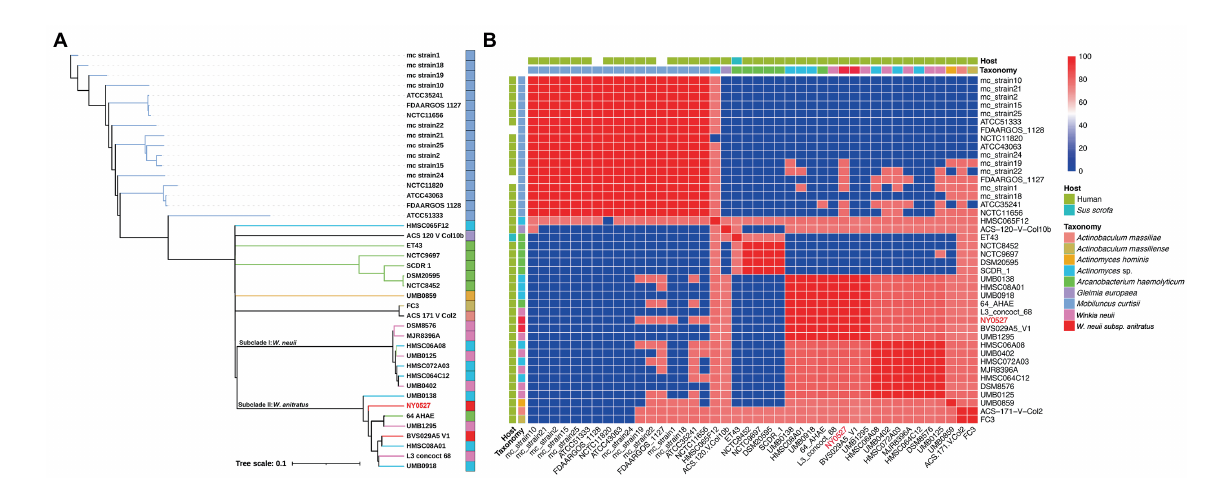
FIGURE 2 Phylogeny of strain NY0527 characterized by a phylogenomic tree and whole-genome-sequence-based ANI analysis. (A) WGS-based phylogenomic tree of phylogenetically close strains. Strain NY0727 is labeled in red. The taxonomy color code is shared with (B) in the legend. (B) Heatmap displaying the ANI between the phylogenetically close species. The color bar on the right indicates the ANI value calculated using